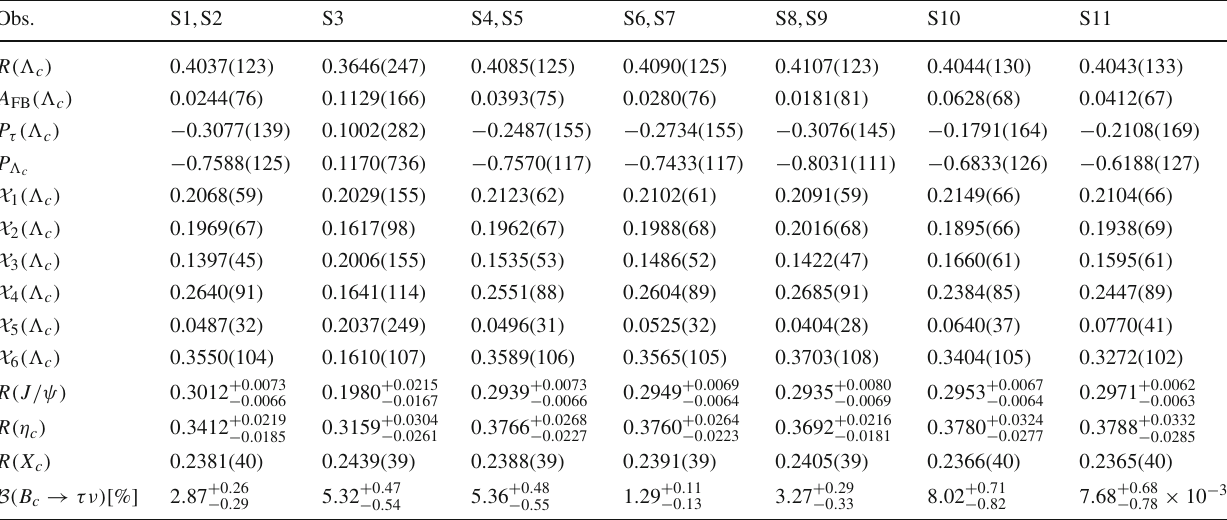
Table 5 Predictions for the observables involved in (cid:4) b → (cid:4) c τν decay, as well as for R ( J /ψ) , R (η c ) , R ( X c ) , and B ( B c → τν) in all the NP